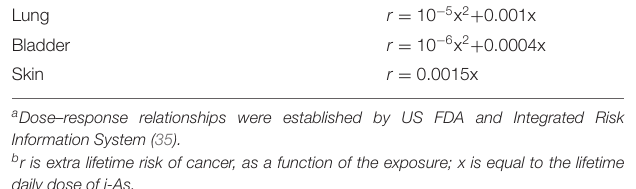
TABLE 2 | Dose–response relationships of the risk of lung, bladder, and skin cancer as a function of dietary exposure to inorganic arsenic (i-As) a . Cancer